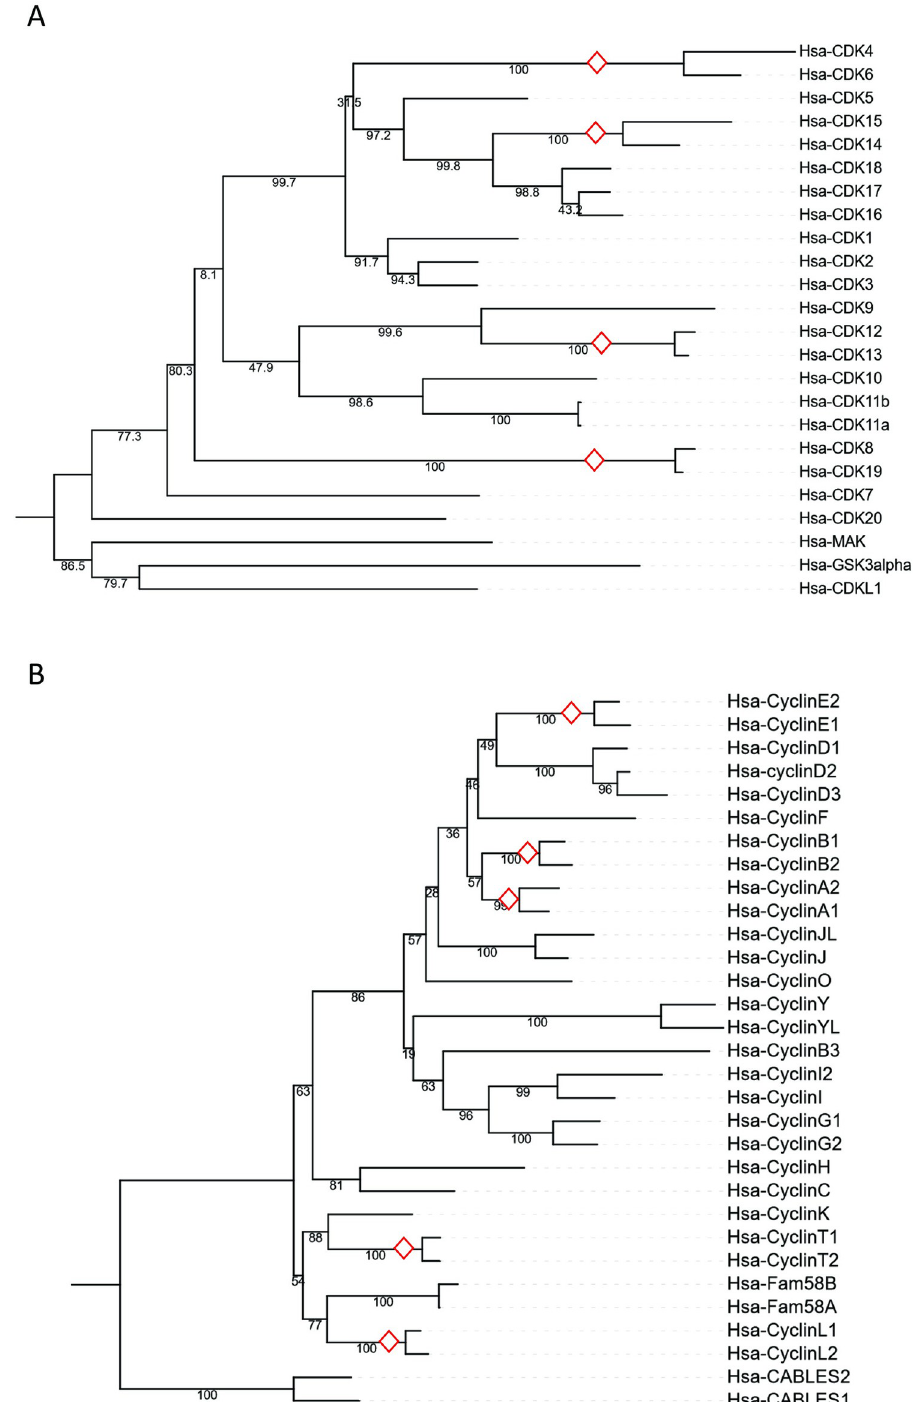
Fig 5. Phylogenetic trees of human CDKs (A) and Cyclins (B) using Maximum likelihood. The trees were realized according to the substitution model LG [192] as calculated by ModelFinder [101] using the AIC [98]. The phylogenetic analyses were performed using IQ-TREE2 [77, 78] and the figure was realized using ITOL [153]. The numbers indicate the bootstrap values as calculated by UFBoot2 [130]. Red squares indicate whole genome duplications according to the database Ohnologs 2.0